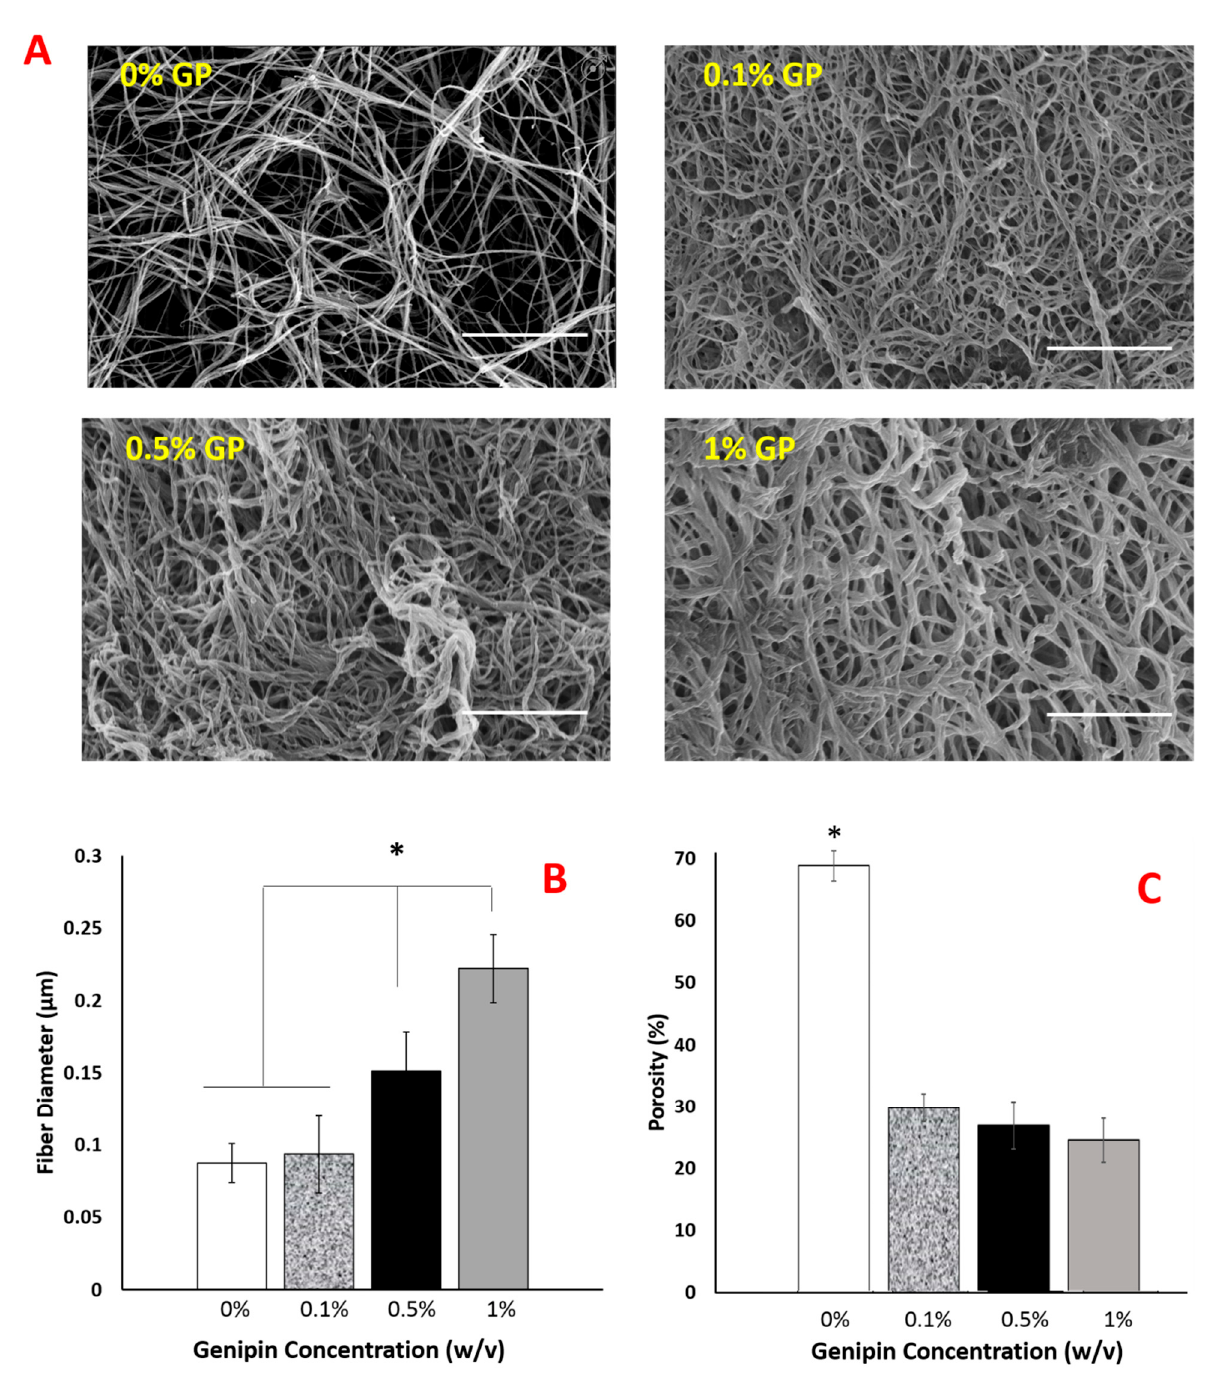
Figure 5. The morphological changes within the scaffolds crosslinked with various genipin concentrations. ( A ) SEM images of scaffolds show increased fiber thickness with increased genipin concentration. Scale bar is 5 µ m for all SEM images. ( B ) The changes in fiber diameter and ( C ) porosity as a function of genipin concentration. (*) indicates a significant difference between sample groups, p < 0.05.